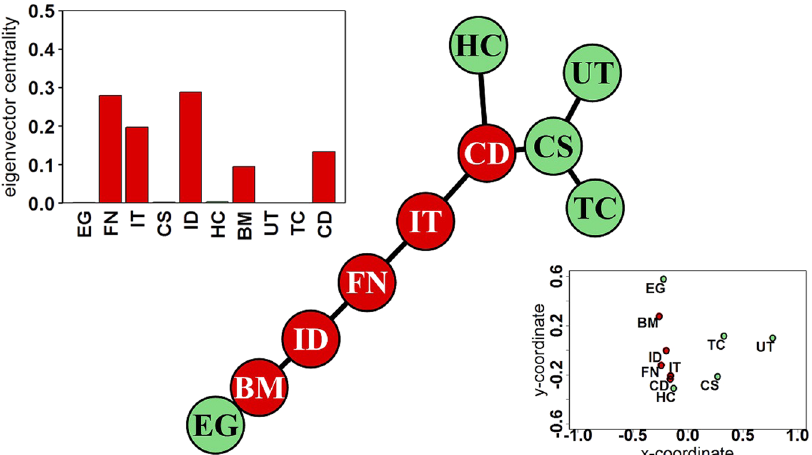
Figure 1. Results for USA: Identification of the sectors that are in the core (red) and periphery (pale green) of the minimum spanning tree, where the nodes represent different sectors; sectoral abbreviations given in the Table 1 in Materials and Methods. Left Inset : Eigenvector centralities of ρ 32 . Right Inset : Multidimensional scaling, where the different sectors are plotted as coordinates in a